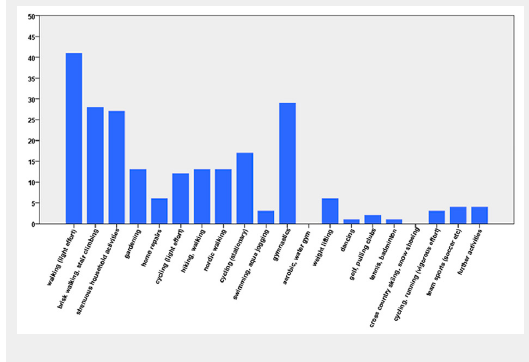
Number of patients who performed the physical activities in a typical week during the previous 2 months; data from questionnaire 1 (n = 48).